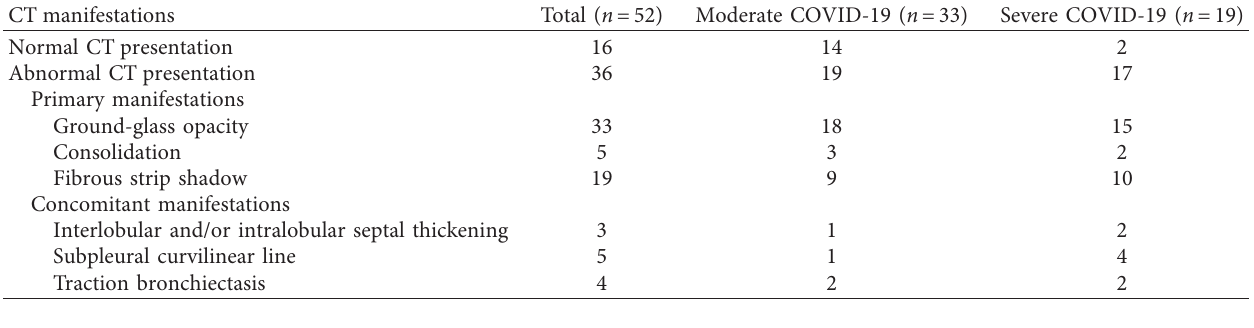
Table 3: CT manifestations of 52 patients with COVID-19 at the first follow-up after discharge.